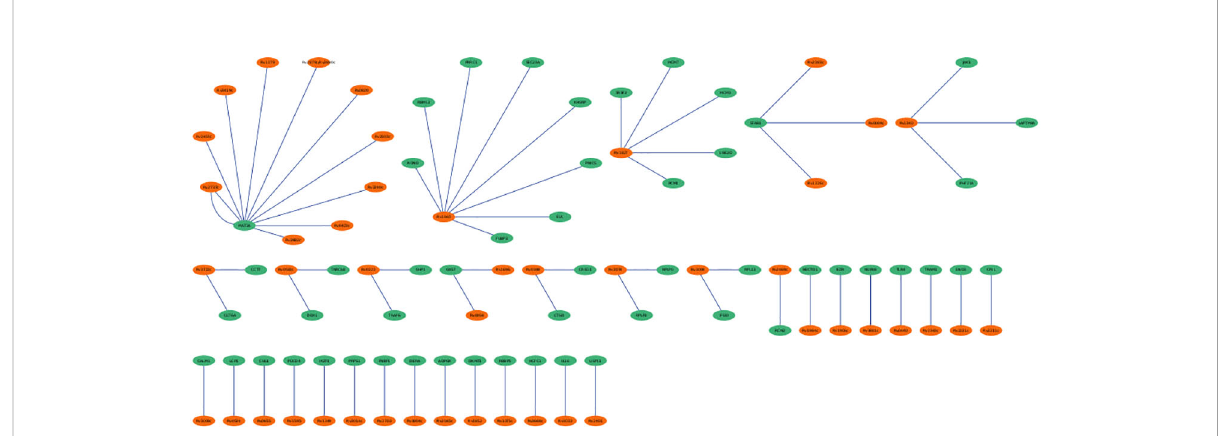
FIGURE 6 Mtb -host protein-protein interaction network (hmPPI). The Mtb proteins are colored green and human proteins are colored in orange. The edges are represented as blue